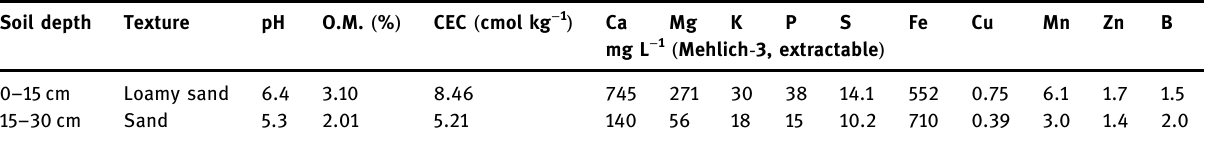
Table 1: Initial soil properties ( before applying any soil amendments )